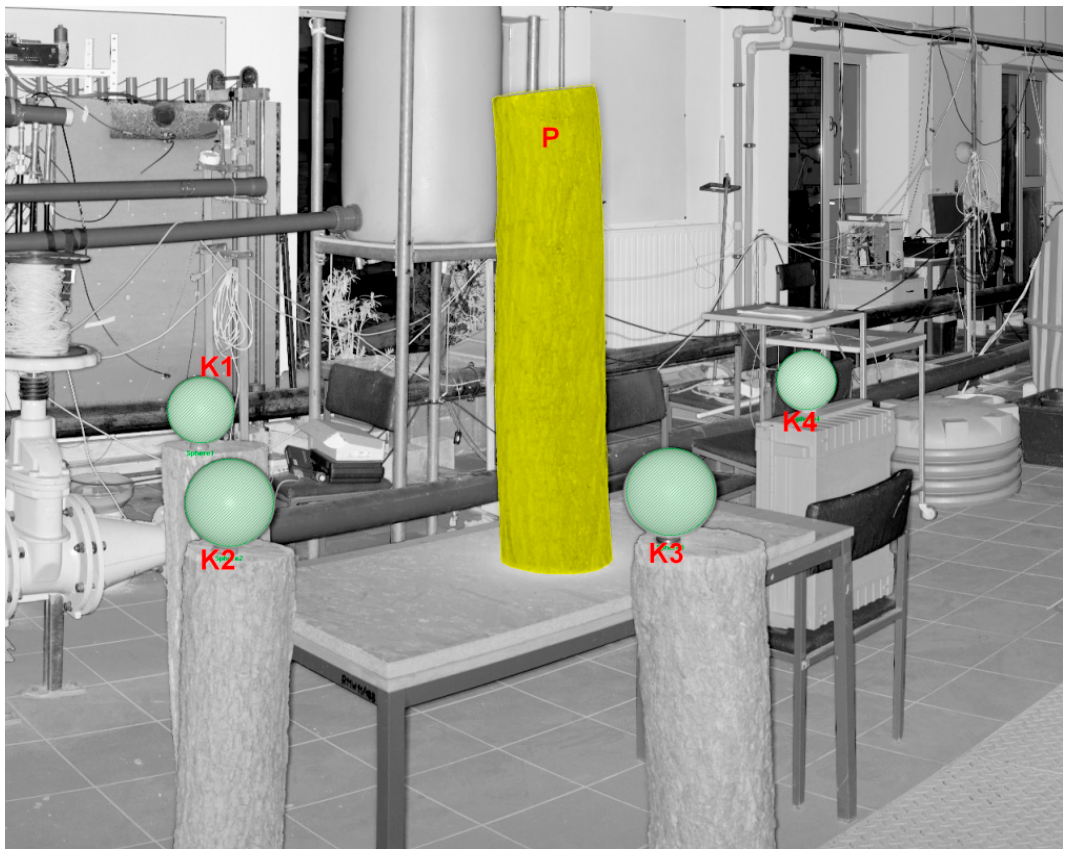
Figure 1. Scan of the trunk (P) with the four reference balls (K); photogrammetric image of point cloud intensity.